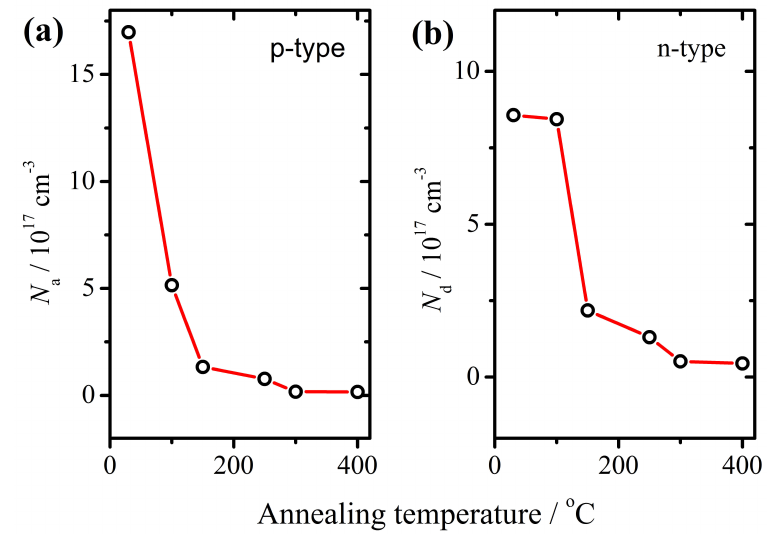
Figure 3. Defect densities of the AAO layer plotted against the annealing temperature. The defect densities of ( a ) acceptor and ( b ) donor decrease with increasing annealing temperature. The annealing temperature of as-grown barrier layer is assigned to be 30 ◦ C.